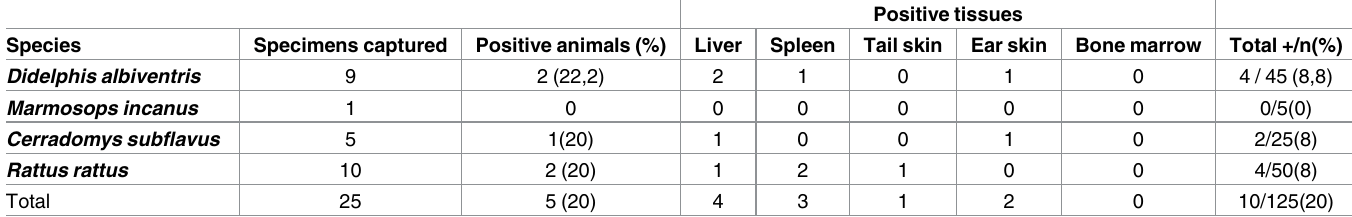
Table 1. PCR positivity for hsp 70 in tissue samples of small mammalscaptured in Casa Branca, Brumadinho, Minas Gerais, Brazil, in the period from May 2013 to June 2014.